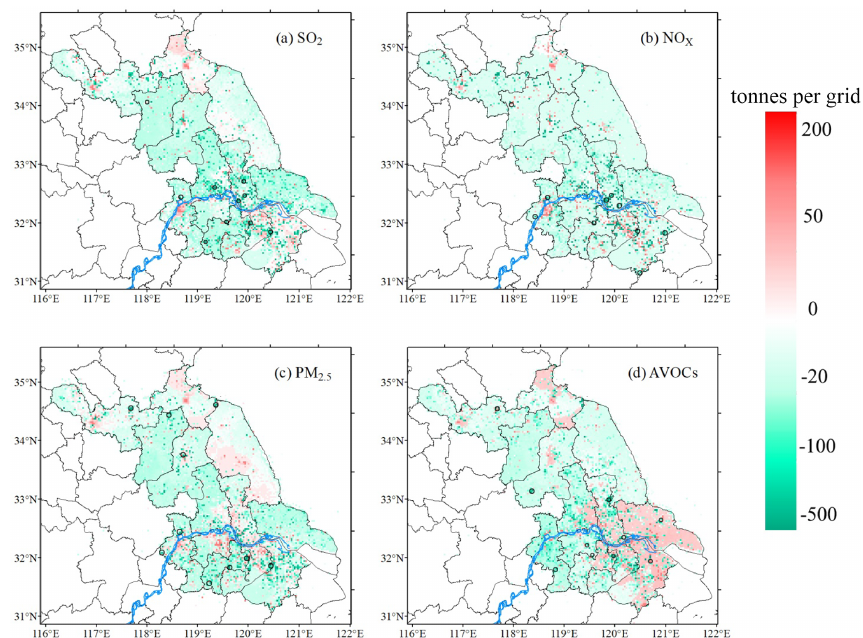
Figure 5. Difference in the spatial distribution of major pollutant emissions between 2015 and 2019 for (a) SO 2 , (b) NO x , (c) PM 2 . 5 , and (d) AVOCs. The black circles represent the locations of top 10 emitters for corresponding species in each panel. The blue line indicates the Yangtze